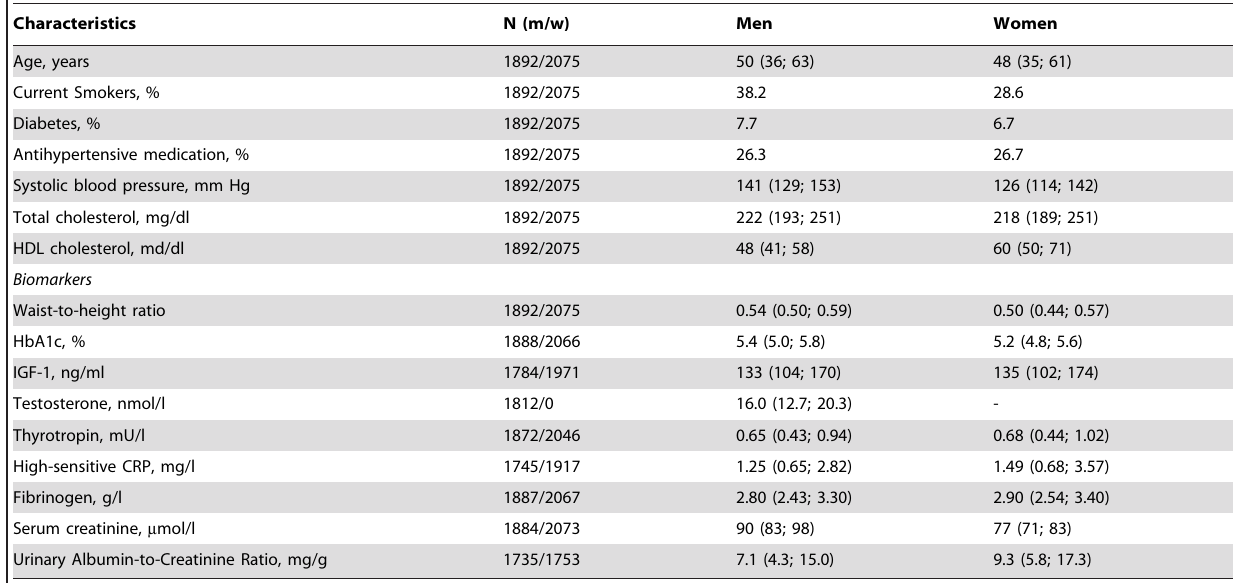
Table 1. Baseline characteristics.